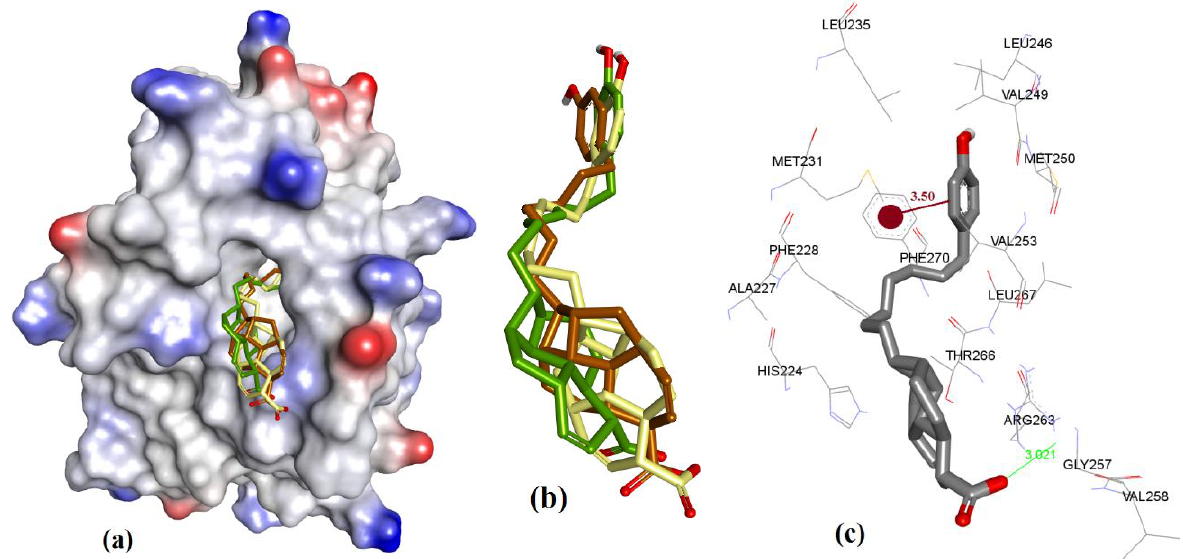
Figure 14. ( a ) The ionized solvent-exposed surface mapping of hMcl-1 along with the docked poses of 4b from MOE (in brown), AutoDock (in green), and VlifeDock (in yellow) show their fitting to the cavity. ( b ) Similar-pose ensemble clustering of all three poses was attained from the three different docking methods. ( c ) Binding mode of 4b .